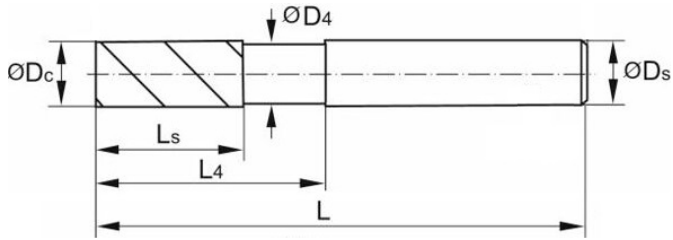
Figure 3. Geometry of endmill used [41]. Table 2. Technical data of tool used [41].